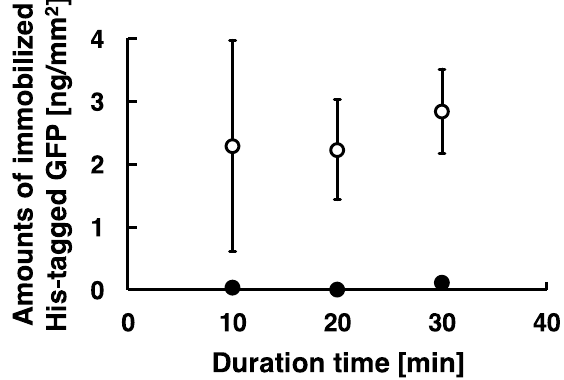
Figure 5. Scatter plots of amounts of immobilized His-tagged GFP by applying AC electric field. The conditions of applying AC electric field are described as follows: 20 Hz at the constant applied voltage of 80 Vpp for the duration time of 10, 20, and 30 min. Open circle and closed circle denote the amounts of immobilized His-tagged GFP after Milli-Q water wash and imidazole treatment. Error bars represent the standard deviations from three independent experiments.